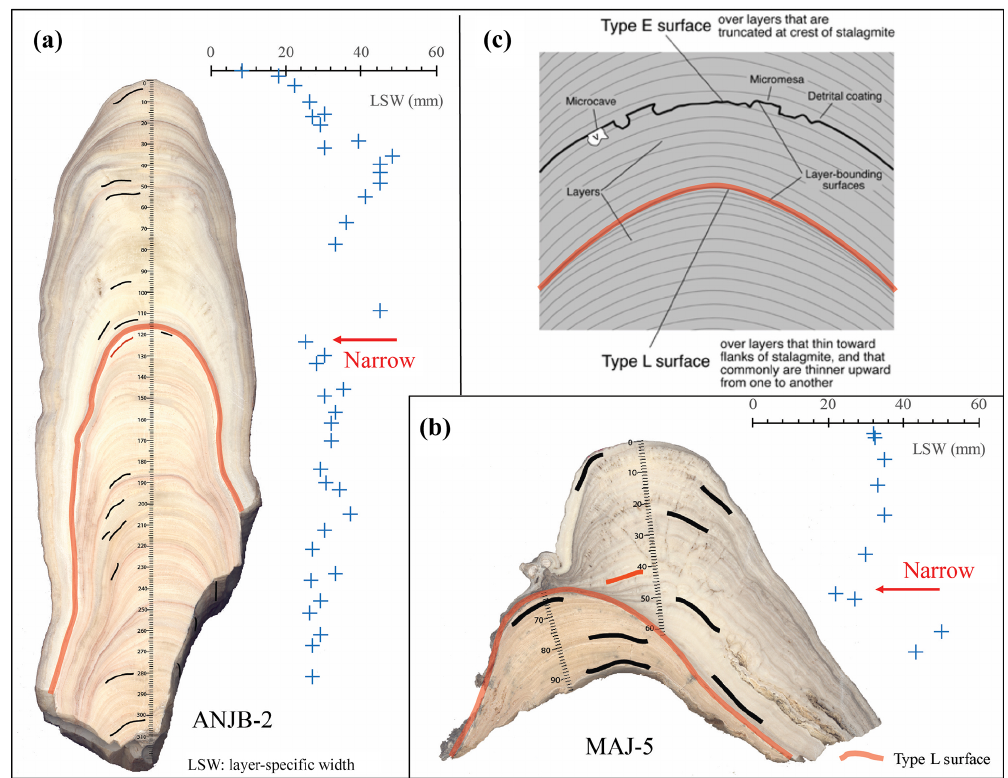
Figure 3. (a) Scanned image of Stalagmite ANJB-2 and the corresponding variations in layer-specific width (LSW). (b) Scanned image of Stalagmite MAJ-5 and the corresponding layer-specific width (LSW). (c) Sketches of typical layer-bounding surfaces (Type E and Type L) of Railsback et al. (2013). Close-up photographs of the hiatuses are shown in Fig.